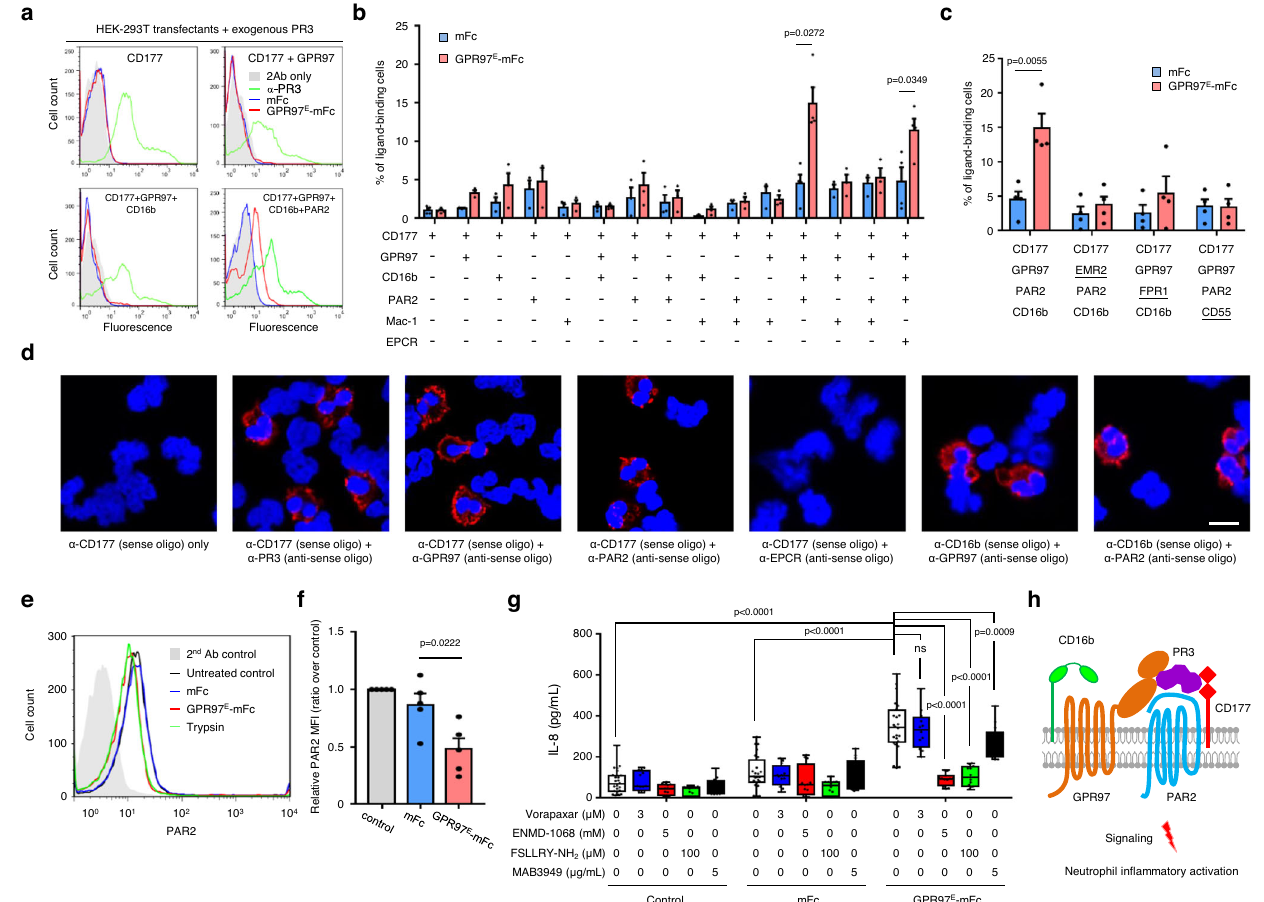
Fig. 5 | The CD177/GPR97/PAR2/CD16b receptor complex is required for ef fi - cient GPR97-mPR3 interaction that induces PAR2 activation. a – c Flow cyto- metry analyses of GPR97-mPR3 interaction in HEK-293T cells expressing various receptors as indicated. a Surface levels of membrane-bound PR3 (green), GPR97 E - mFc (red), and mFc (blue) were detected using appropriate Abs. b , c The percen- tage of transfectants displaying the positive GPR97 E -mFc binding signal in